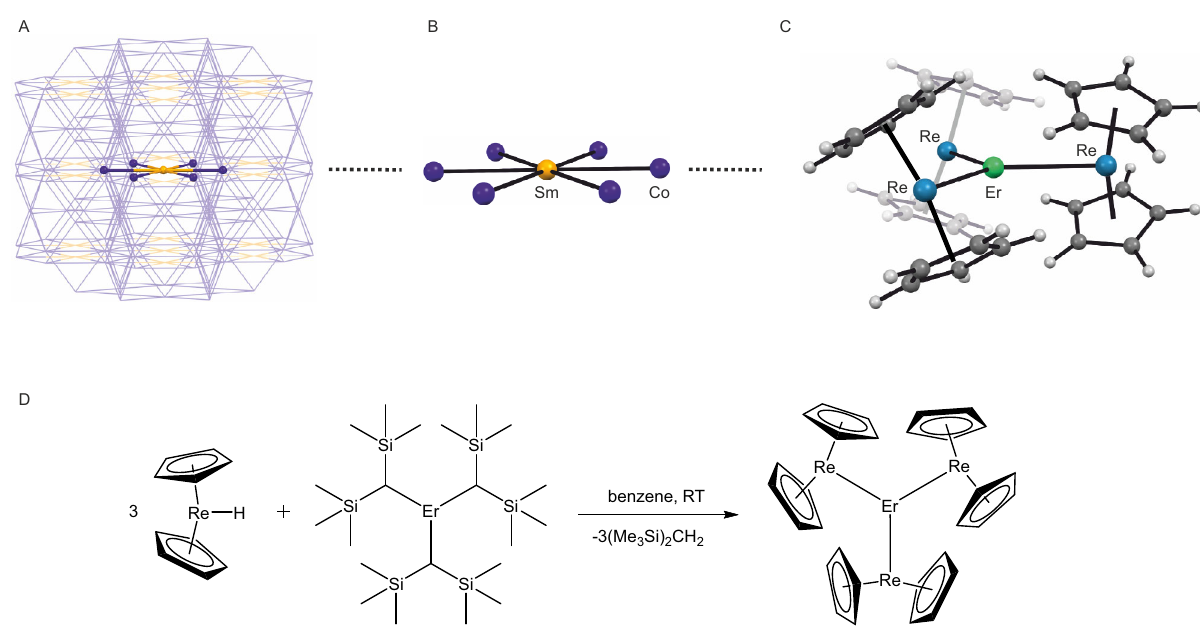
Fig. 1 The synthetic strategy towards ErRe3 and its structure. Graphical representation of the structural design transfer from the intermetallic magnet SmCo 5 ( A , B ) to the molecular nanomagnet [Er III (Re I Cp 2 ) 3 ] ( C ). The hexagonal planar SmCo 6 coordination with unsupported coordination bonds between the center of the rare earth and six transition metals in SmCo 5 ( A , B ) is mimicked by the trigonal planar coordination in ErRe 3 ( C ). All three panels A – C are based on single-crystal structural models of SmCo 5 1 and ErRe 3 . Sm-Co bonds in SmCo 5 : 2.888 Å; Er-Re bonds in ErRe 3 : 2.9004(5), 2.9124(5), 2.9172(5) Å. Panel D presents the synthesis of ErRe 3 based on the work of Kempe et al. 32 . This approach utilizes the reaction of the weak Brønsted acid [Cp 2 ReH] with the strong Brønsted base btmsm − in [Er III (btmsm) 3 ] in benzene at room temperature (RT) resulting in (Me 3 Si) 2 CH 2 elimination and the formation of [Er III (Re I Cp 2 ) 3 intermetallic SmCo 5 with Sm-Co distances of 2.888 Å 1 . The susceptibility) value of 11.3 cm 3 K mol − 1 at 260 K is close to comparison of the Re-Cp distances in ErRe 3 and the [Cp 2 ReH] 11.48 cm 3 K mol − 1 expected for a single Er III 4 I 15/2 ground multiplet (Supplementary Fig. 5). A similar agreement between the experi- ment and the expected χ T was reported for [Sm III (Re I Cp 2 ) 3 ] ( 6 H 5 ∕ 2 multiplet) 32 . This is further con fi rmed by a very good agreement of the experimental χ T and the ab initio calculations (red solid line in Supplementary Fig. 5 and supplemental information) using Molcas 53,54 . The χ T ( T ) dependence shows an abrupt increase below 18 K, which can be ascribed to ferromagnetic intermolecular inter- actions and blocking of magnetization. The M ( H ) ( M — molar magnetization, H — magnetic fi eld) measurements (magnetic fi eld sweep rate of 2.2 mT s − 1 ) revealed the presence of waist-restricted (pinched) magnetic hysteresis loops up to 7.2 K (Fig. 2A), originating from the slow relaxation of the magnetization of the trigonal ErRe 3 . This temperature matches Er III sandwich and metallocene complexes 55 . Further- more, the hysteresis loop in ErRe 3 opens in the 0.05 – 1.5 T range at 1.8 K and is the widest among trigonal Er III MNMs. The slow magnetization dynamics were studied and con fi rmed by the alternating current (AC) magnetic suscept- ibility measurements performed in the 1 – 10000 Hz frequency range up to 27 K in the absence of the external magnetic fi eld (Fig. 2C and Supplementary Table 2). However, the resulting temperature dependence of the magnetic relaxation rate τ − 1 ( T ) (Fig. 2D) contains contributions from three processes: quantum tunneling of magnetization (QTM), Raman and Orbach described by fi ve parameters included in Eq. 1: